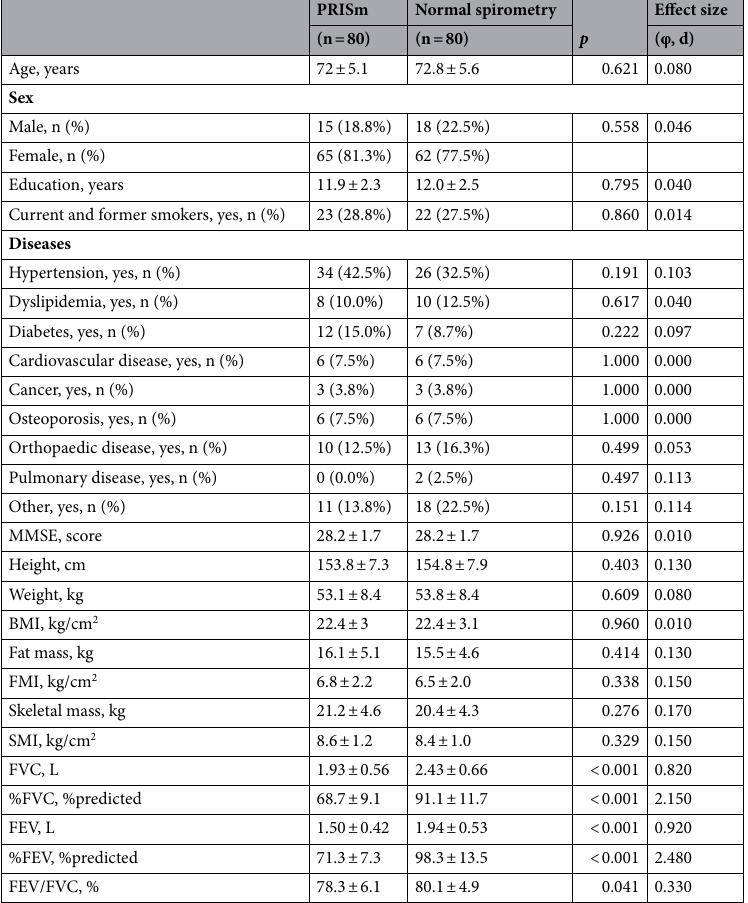
Table 3. Comparison of the sociodemographic, clinical, and physiological characteristics of the PRISm and normal spirometry groups. BMI Body mass index, CS-30 30-s stand test, FEV Forced expiratory volume, FMI